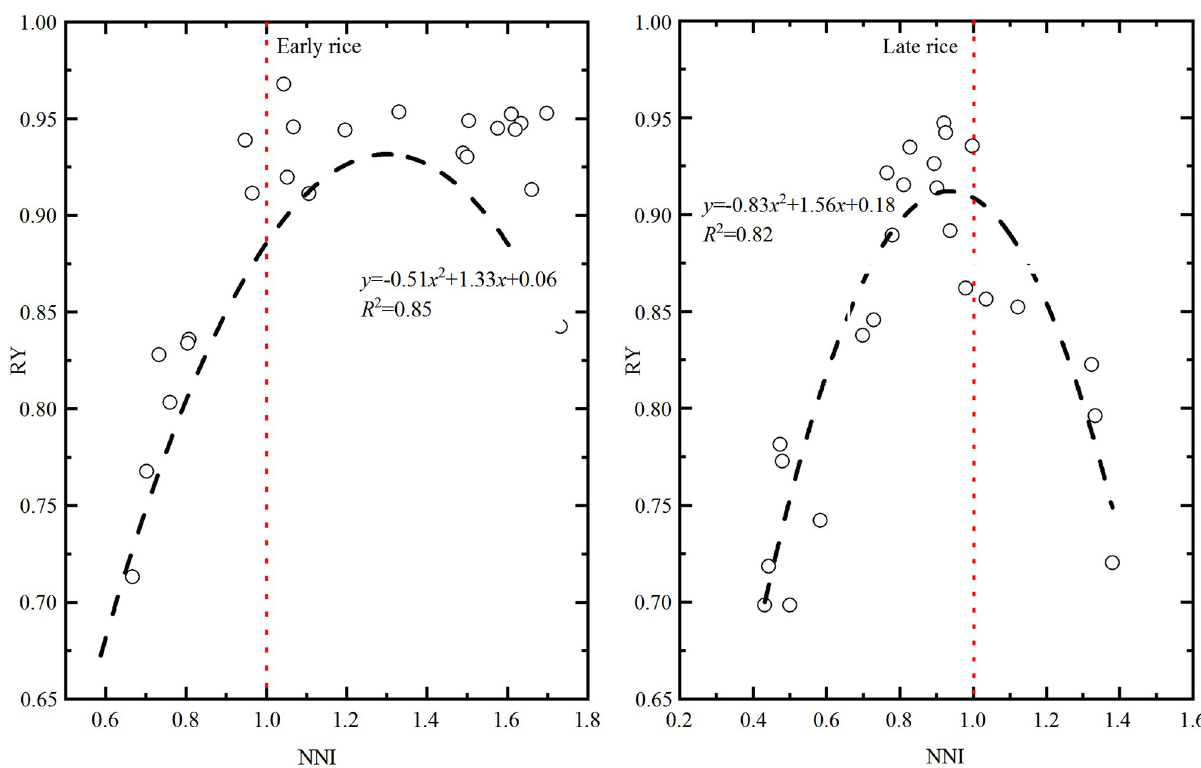
Fig 5. Relationship between nitrogen nutrition index (NNI) and the Relative Yield (RY) of rice.